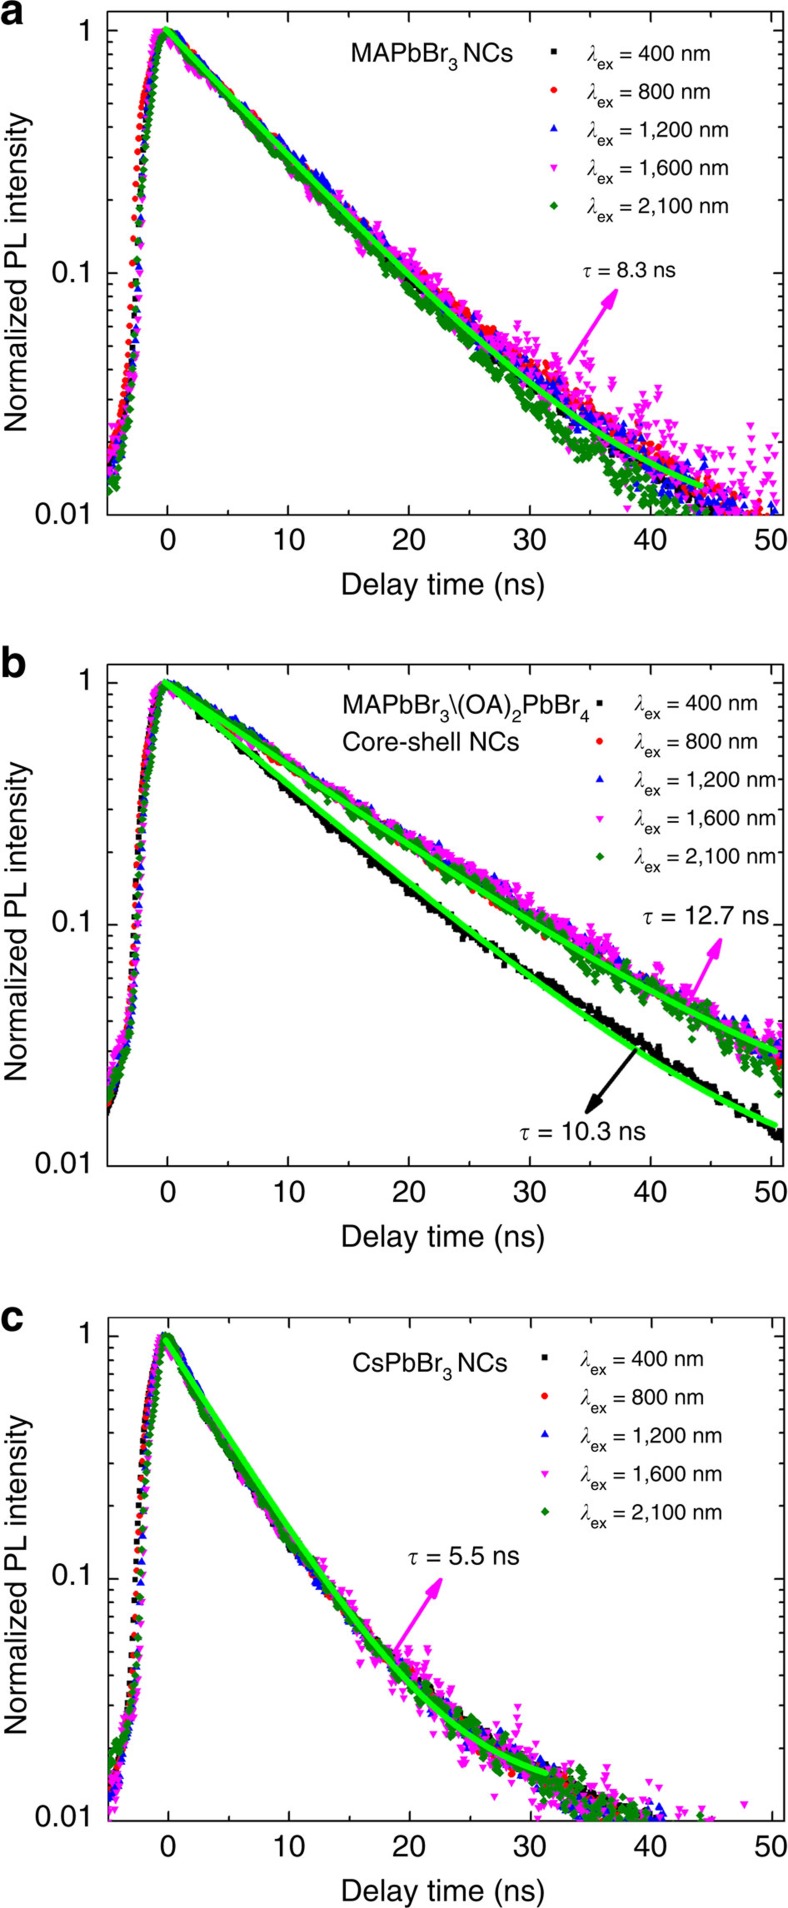
Comparison between the PL decay traces of the perovskite NCs under various multi-photon excitations.(a) One- and multiphoton-excited PL decay curves in MAPbBr3 NCs. (b) Longer one- and multiphoton-excited PL decay lifetimes are obtained for MAPbBr3/(OA)2PbBr4 NCs than for MAPbBr3 NCs. (c) Shorter PL decay lifetimes in CsPbBr3 NCs under one- and multiphoton excitation.